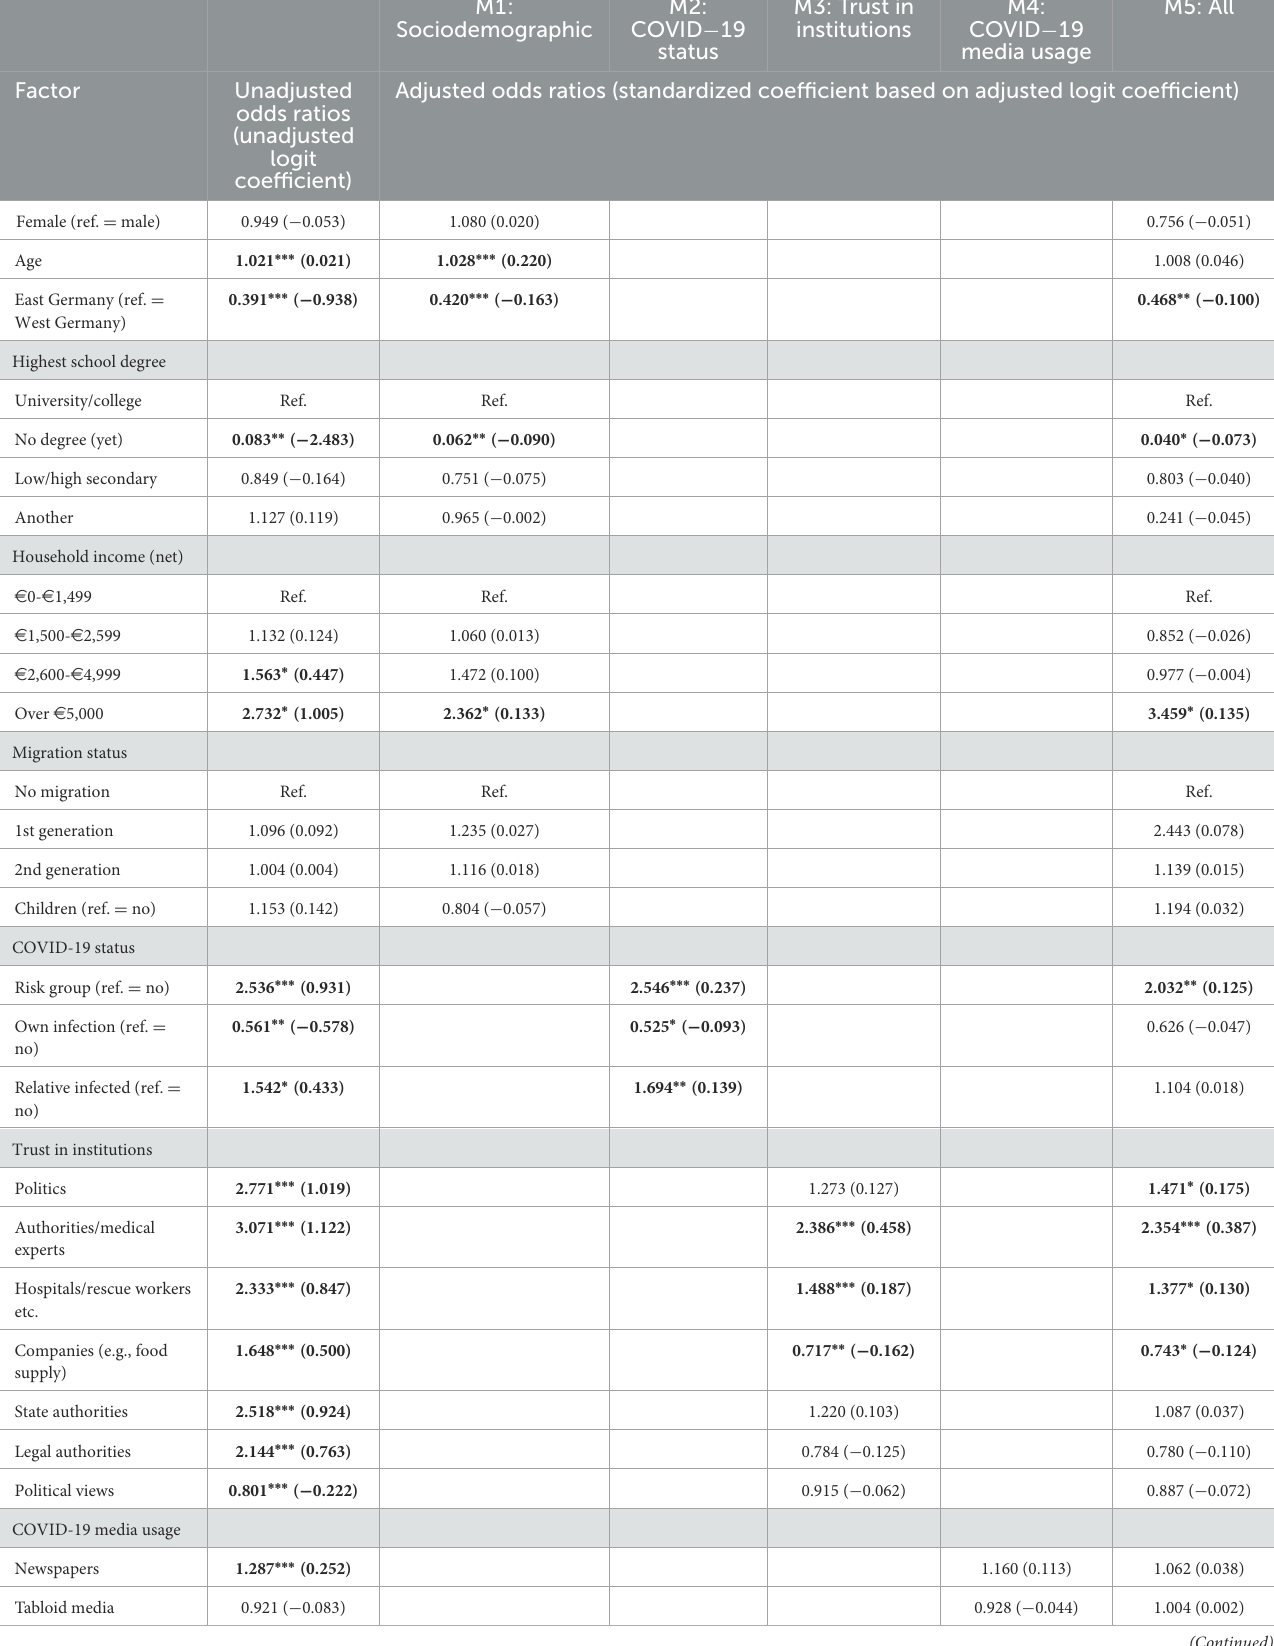
TABLE 2 Logistic regression results using vaccination status (0 ”not vaccinated against COVID-19,” 1 ”vaccinated against COVID-19”) as the criterion. M1: